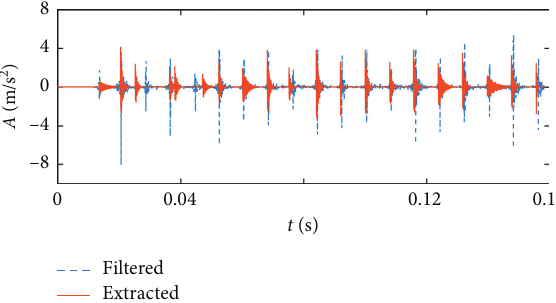
Figure 7: Filtered noiseless signal and extracted feature signal under 5 dB noise condition.